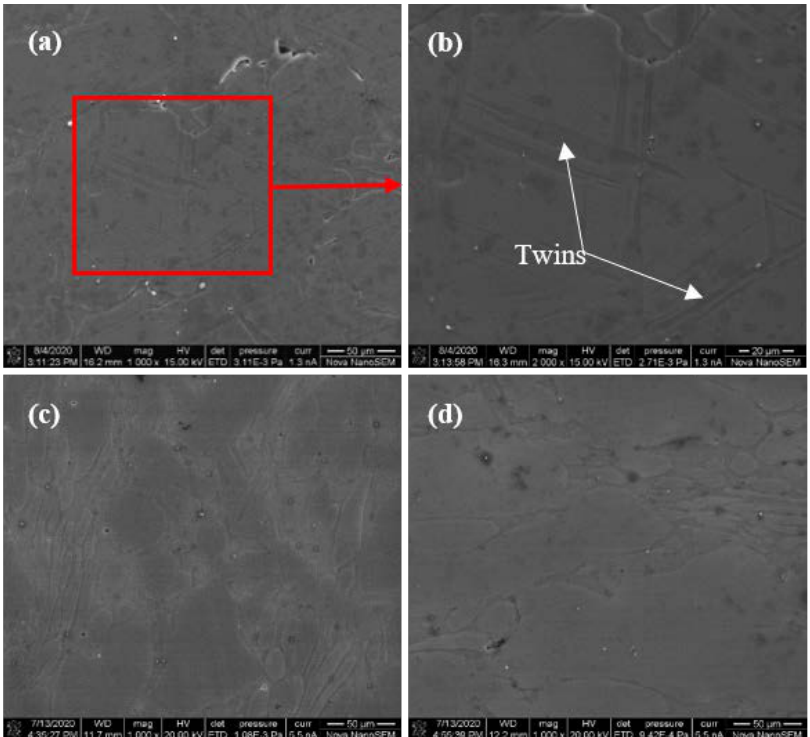
Figure 11. SEM image of Mg-6Li alloy: ( a , b ) with different magnification at 423 K and 0.1 s − 1 . ( c ) 473 K-0.01 s − 1 . ( d ) 573 K-0.01 s − 1 .